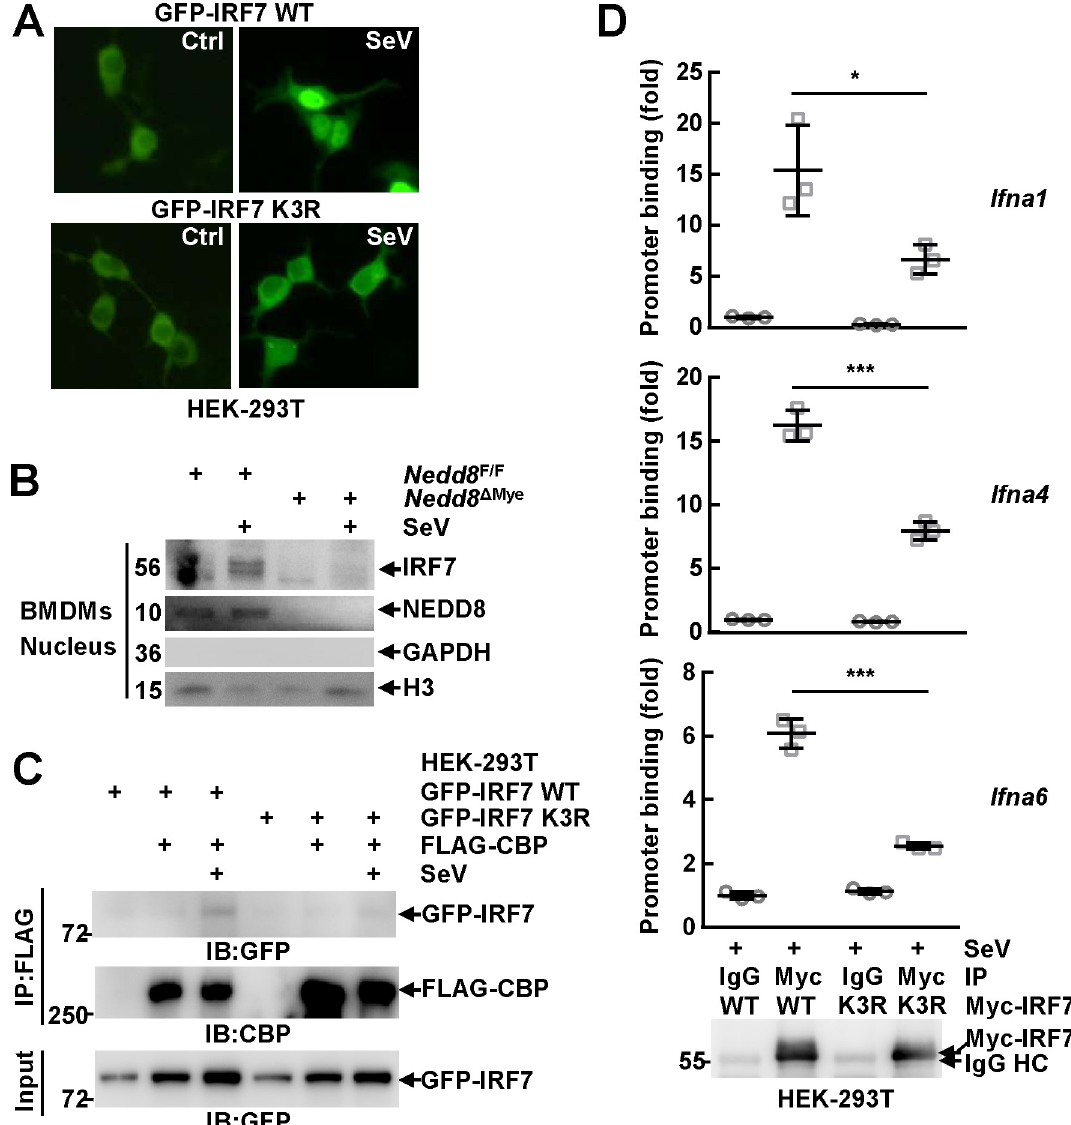
Fig 6. The neddylation of mammalian IRF7 facilitates its nuclear translocation. (A)Twenty-four hours after HEK-293T cells were transfected with mammalian expression vectors encoding GFP-tagged murine IRF7 WT and K3R mutant, the cells were infected with SeV for 6 h or left untreated. Then the subcellular localization of exogenous murine IRF7 was examined via confocal microscopy. (B) After BMDMs were cultured from Nedd8 F/F and Nedd8 Δ Mye mice, the cells were infected with SeV for 6 h or left untreated. The subcellular localization of IRF7 was examined by nuclear cytoplasmic fractionation and subsequent IB. GAPDH was regarded as a cytoplasm marker and H3 as a nucleus marker. (C, D) Twenty-four hours after HEK-293T cells were transfected with the indicated mammalian expression vectors, the cells were infected with SeV for 6 h or left untreated. Then the interaction between exogenous murine IRF7 and exogenous murine CBP was determined by Co-IP (C). The specific binding of exogenous murine IRF7 to selected Ifna gene promoters within the chromatin was analyzed by ChIP with an anti-Myc antibody (D, Top ). Immunoprecipitated exogenous murine IRF7 was analyzed by IB analysis (D, Bottom ). Quantitative data are shown as Mean ± SD ( n = 3 per group). � p < 0.05; ��� p <